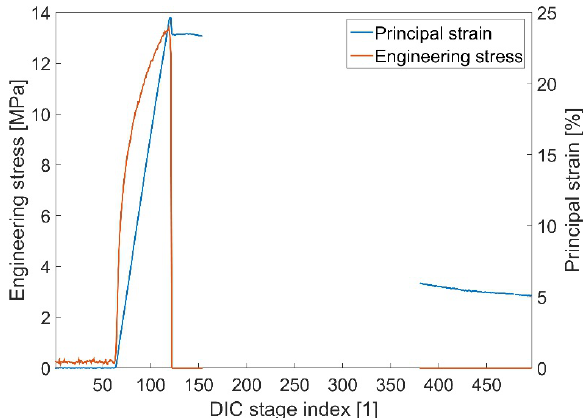
Figure 3. Non-isothermal tensile test with recovery to mimic the thermoforming process.